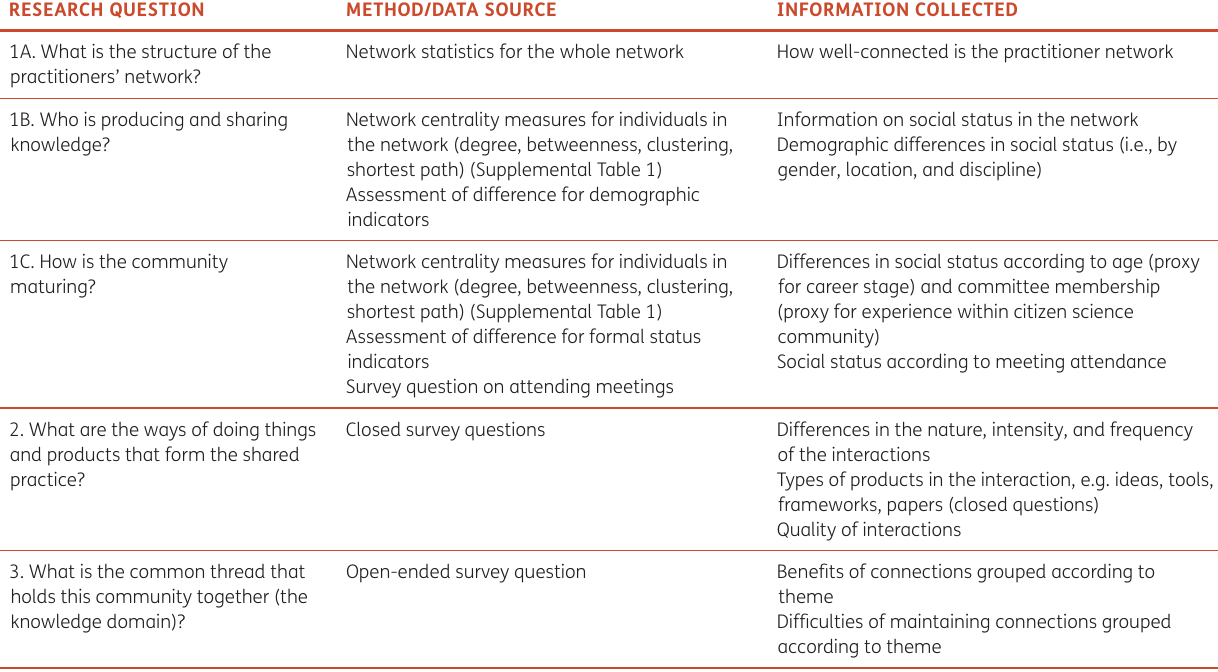
Table 1 Analytical methods for this study.